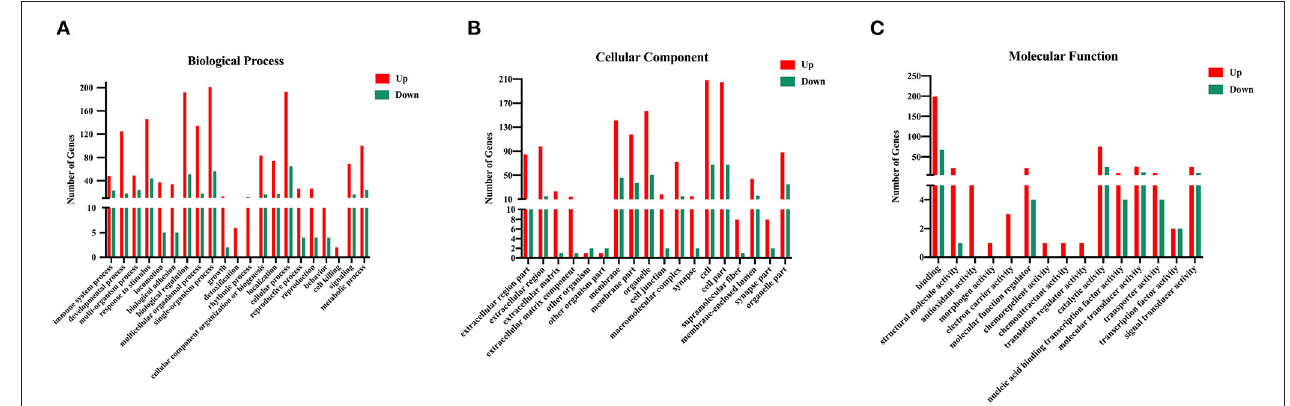
FIGURE 3 | Gene Ontology (GO) analysis of the DEGs in the splenic B cells infected with the larval E. granulosus . GO annotation of DEGs with remarkable enrichment scores covering domains of (A) biological processes, (B) cellular components, and (C) molecular functions. The GO terms with FDR (corrected P -value) ≤ 0.05 were considered